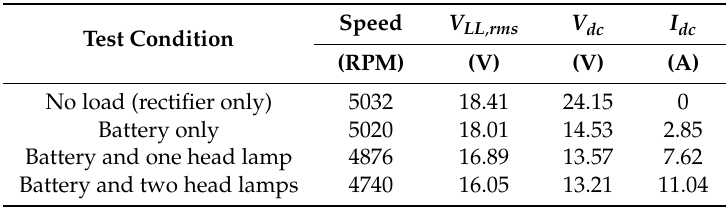
Figure 27. Distorted line–line output voltages due to increased load current; ( a ) without rectifier and no load at 5085 rpm; ( b ) with rectifier and no load at 5032 rpm; ( c ) with rectifier and charging current of 11 A at 4740 rpm. Table 5. AFPMA and AC/DC converter under loading conditions vs. no load condition